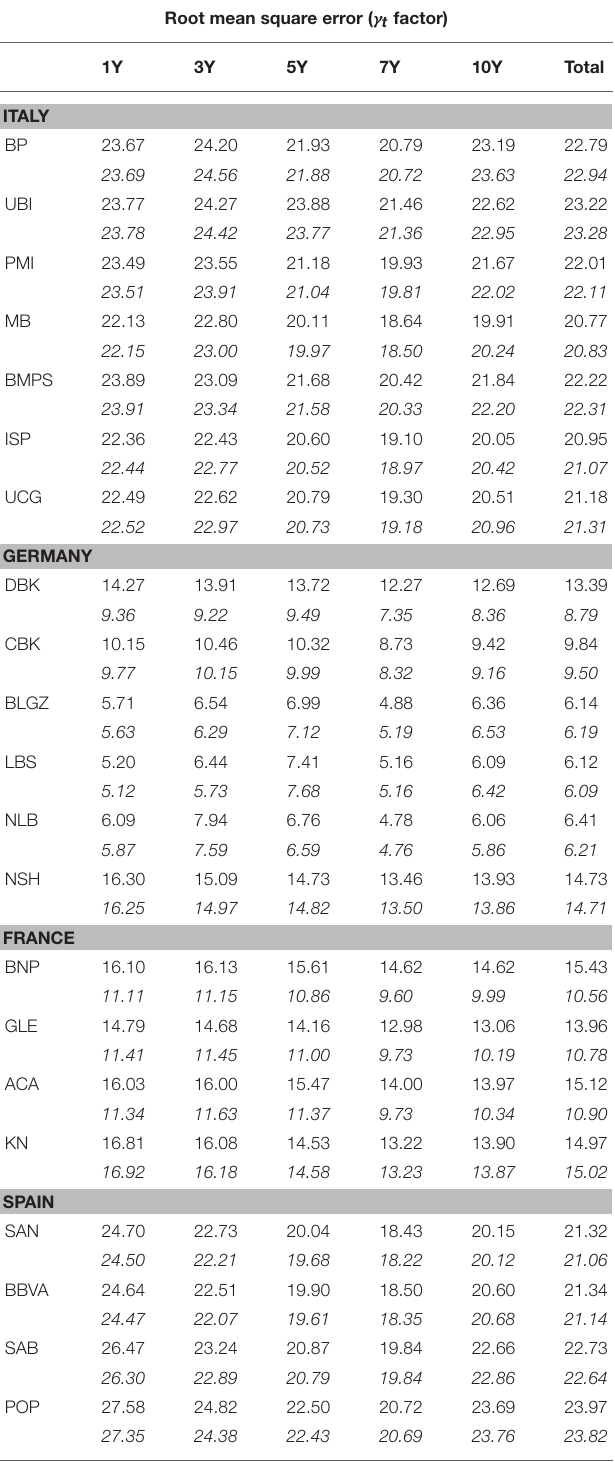
TABLE 4 | Calibration error of the multi-factor Vasicek